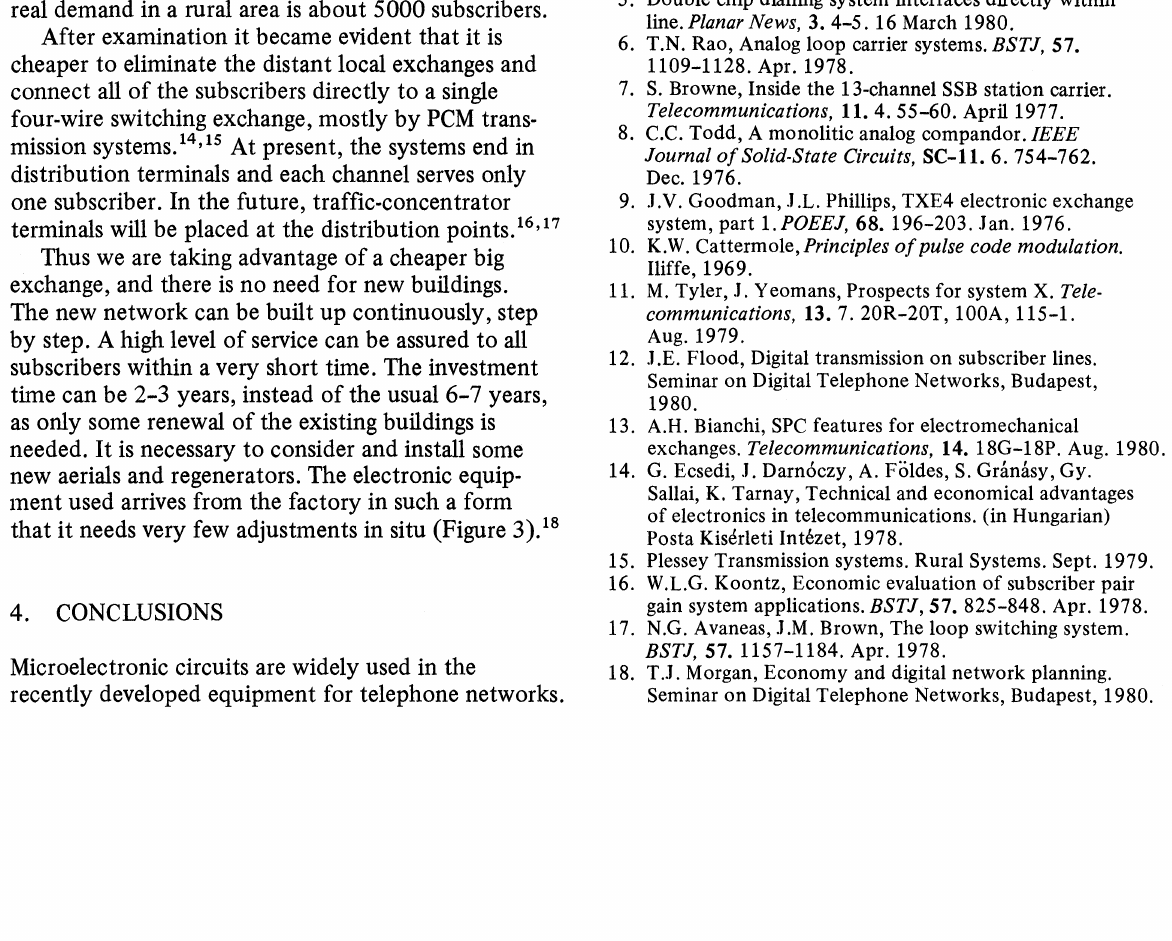
Reconstruction of telephone system using electronic